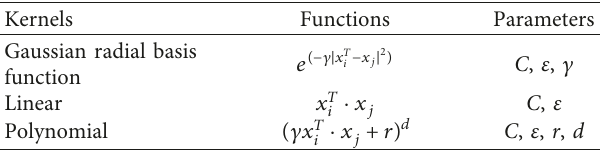
Table 1: Common kernel functions and their hyperparameters in SVR. Kernels